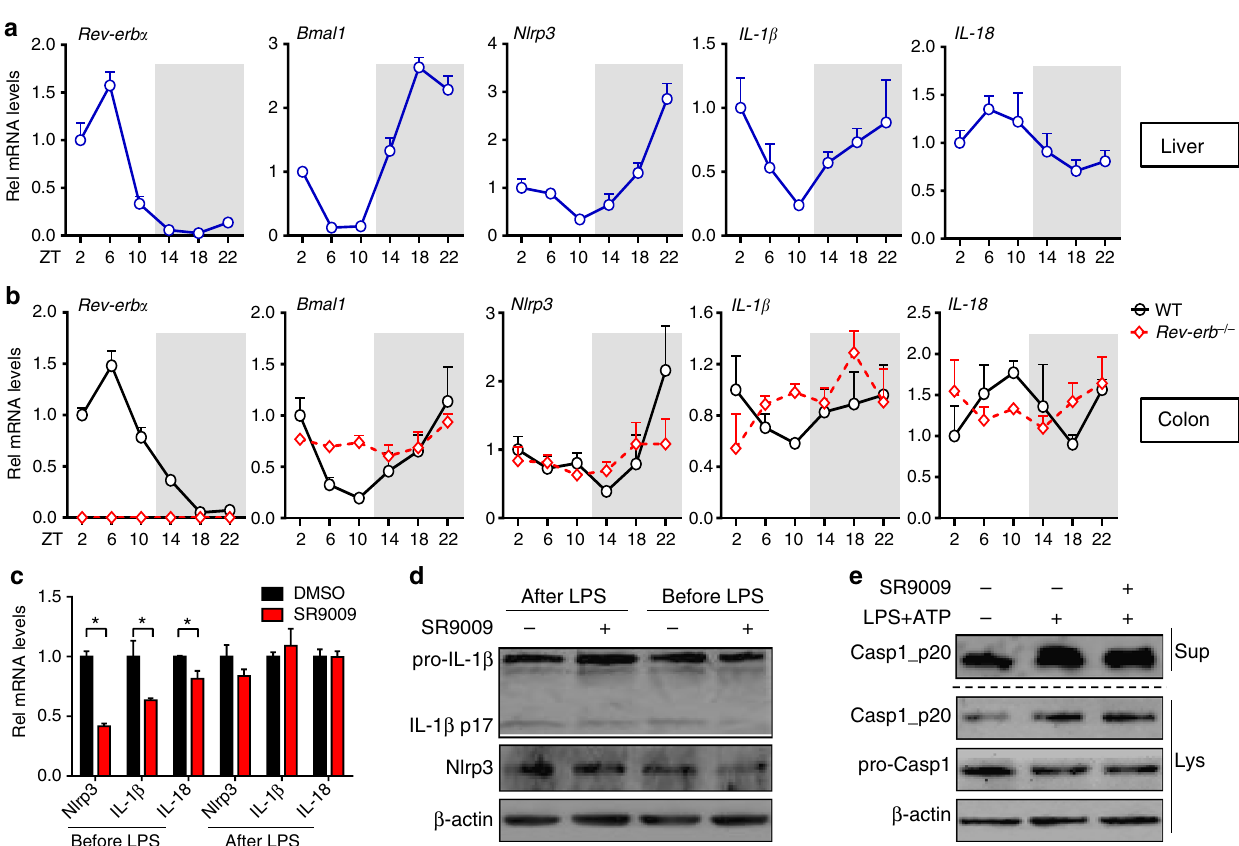
Fig. 3 Identi fi cation of Nlrp3 as a clock-controlled gene. a qPCR assays on circadian gene expressions of lives from WT mice. Data are mean ± SD ( n = 5). b qPCR assays on circadian expressions of colons from WT and Rev-erb α − / − mice. Data are mean ± SD ( n = 5). c qPCR measurements of Nlrp3 and related genes in PMs after co-treatment of SR9009 (for 8 h) and LPS. LPS was added before or after SR9009 treatment. Data are mean ± SD ( n = 3). * P < 0.05 (Mann – Whitney U test). d Western blotting of PMs after co-treatment of SR9009 (for 12 h) and LPS/ATP. LPS was added before or after